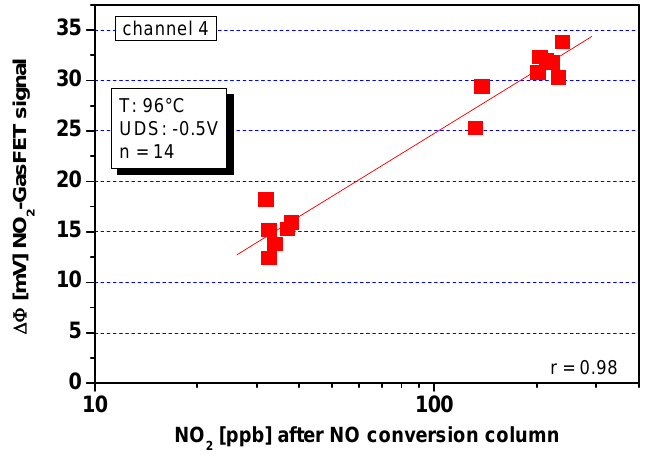
Figure 24. Results for the NO 2 detection in simulated human breath using the NO to NO 2 converter and a GasFET equipped with a Cu-Phthalocyanine sensing layer. The rise of the NO content from the normal value of up to 30 ppm to the threshold of 100 ppm can be clearly